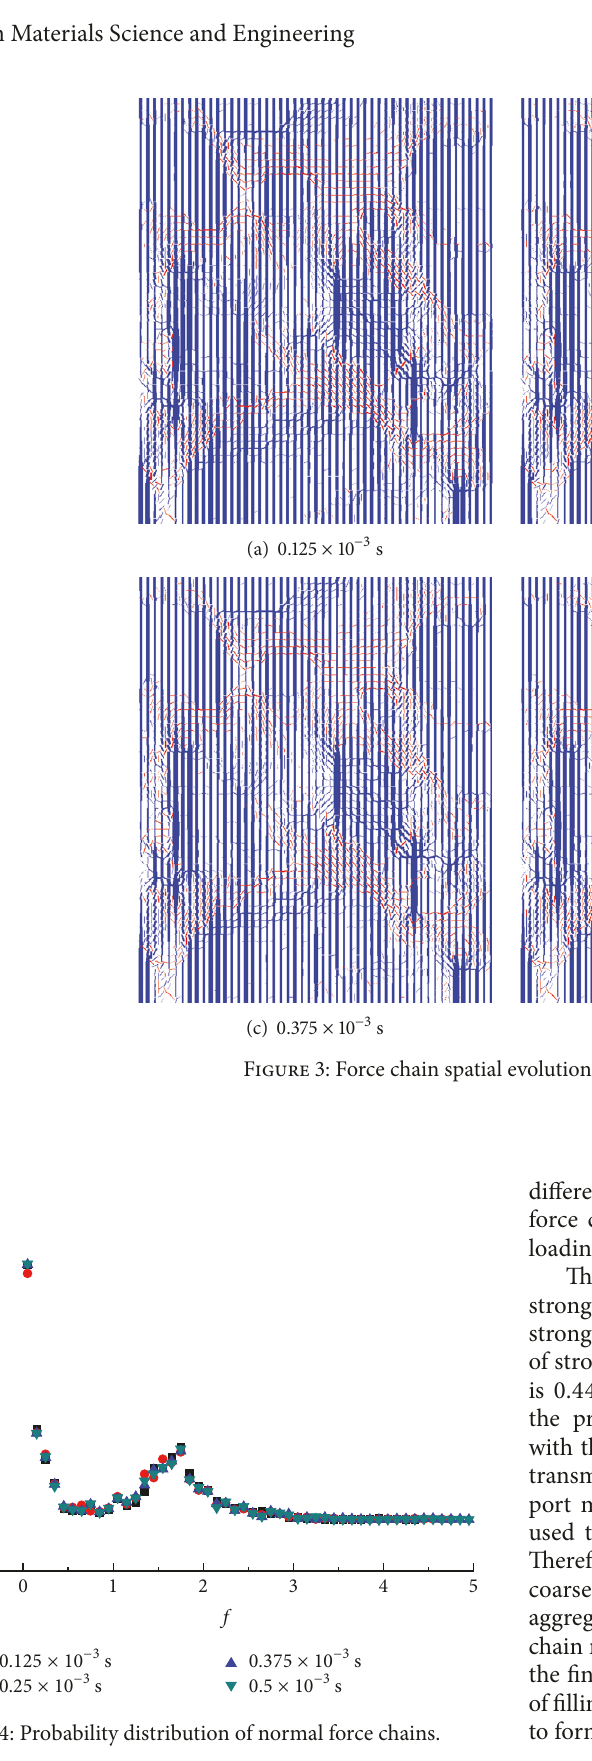
Figure 4: Probability distribution of normal force